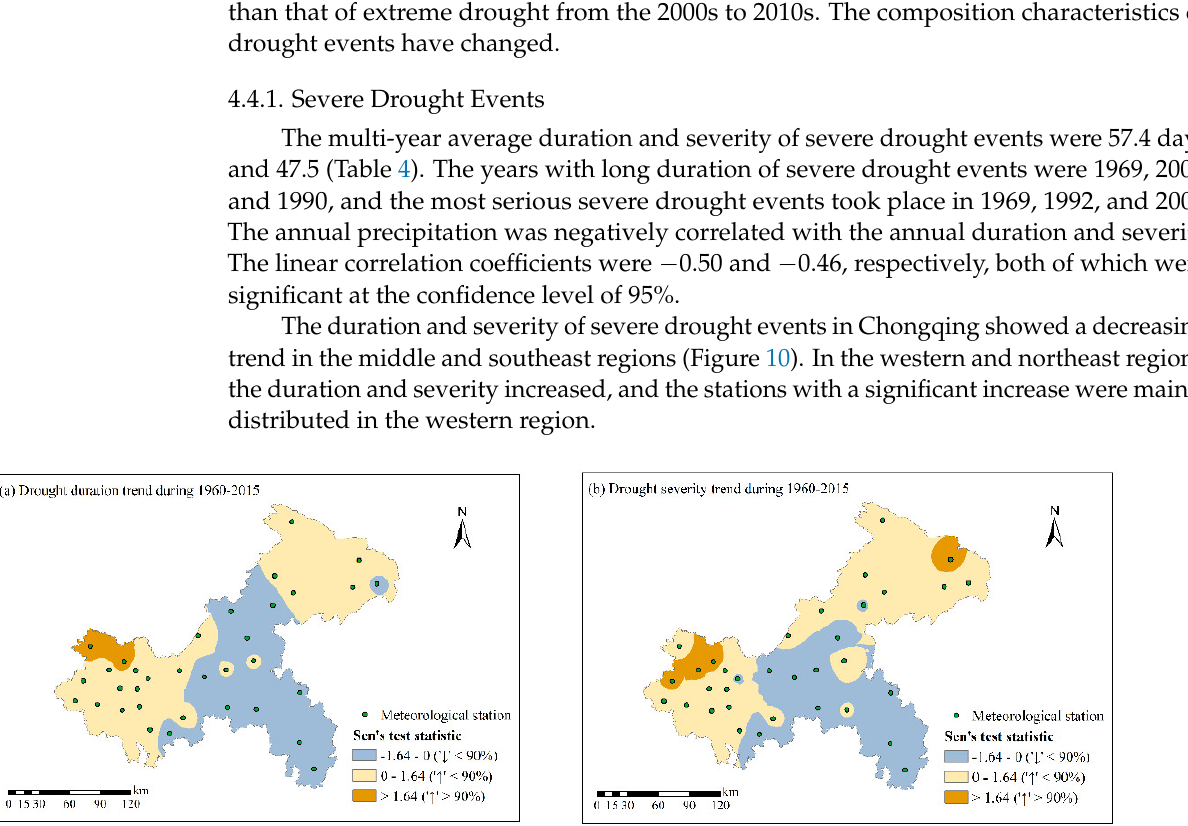
Figure 10. Spatial trend evolution of annual drought duration ( a ) and drought severity ( b ) of severe drought events from 1960 to 2015.